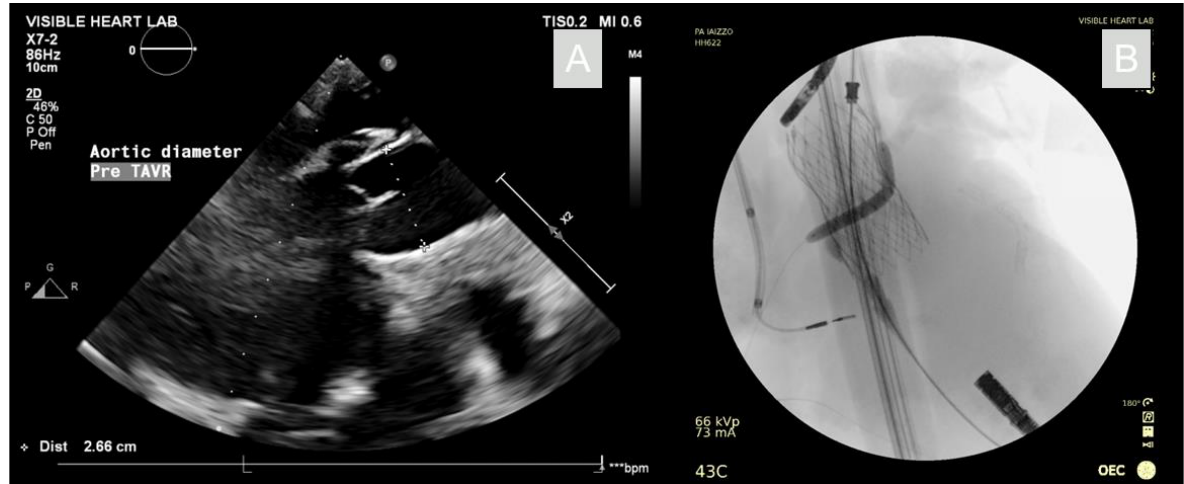
Figure 2. Echocardiography with aortic diameter measurement for prosthesis sizing ( A ). Fluoroscopy of the deployed TAVR and chimney stent with deployment balloon inflated ( B ).